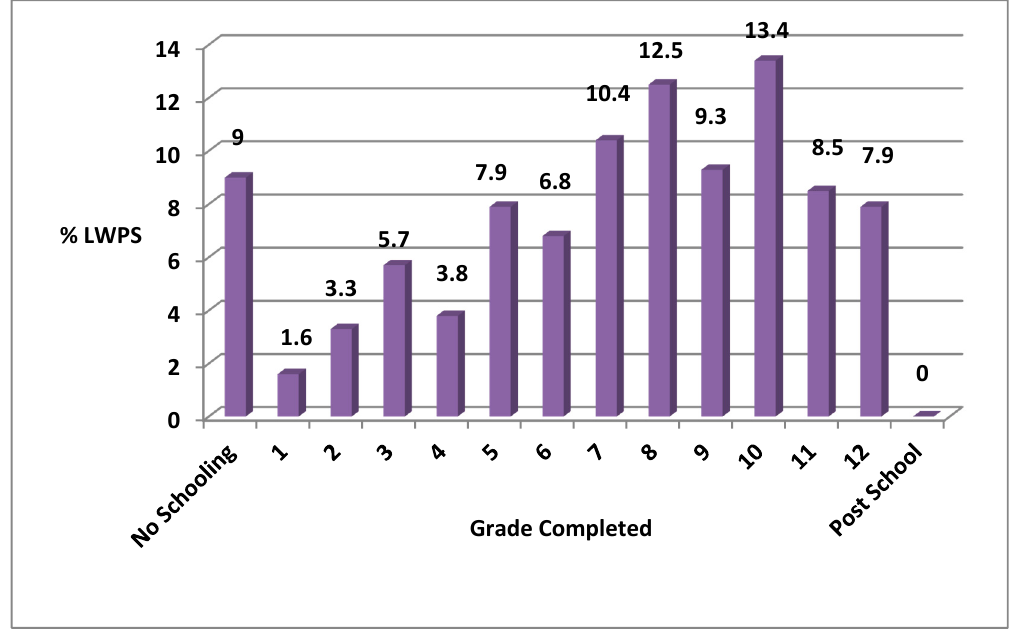
Figure 2. Highest qualification attained by landfill waste pickers (LWPs). Source: Survey data.